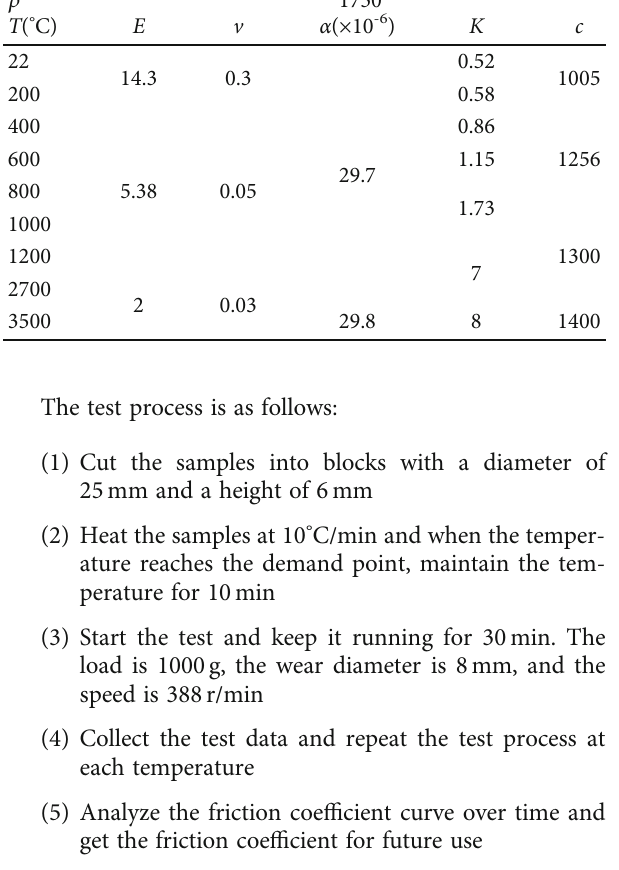
Parameter Design Language (APDL) in ANSYS Workbench